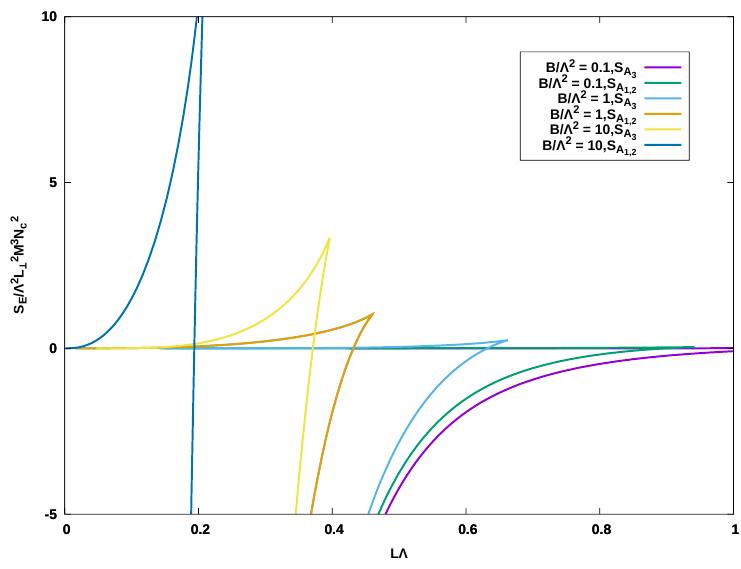
Figure 7 . Entanglement entropy as a function of the strip length (in units of Λ ∼ 1 GeV) when the anisotropic deformation is turned off ( a = 0 ) and c = 0 . 25 . The various plots correspond to different orientations of the strip with respect to the magnetic field and different values of B . In all cases we observe a transition to a disconnected configuration at large distances, signaling a disentangling transition, analogous to the confinement-deconfinement transition of [97]. The effect of the magnetic field is always monotonic: as we increase B the transition is pushed to smaller values of the strip length, in qualitative agreement with other holographic models with a magnetic field